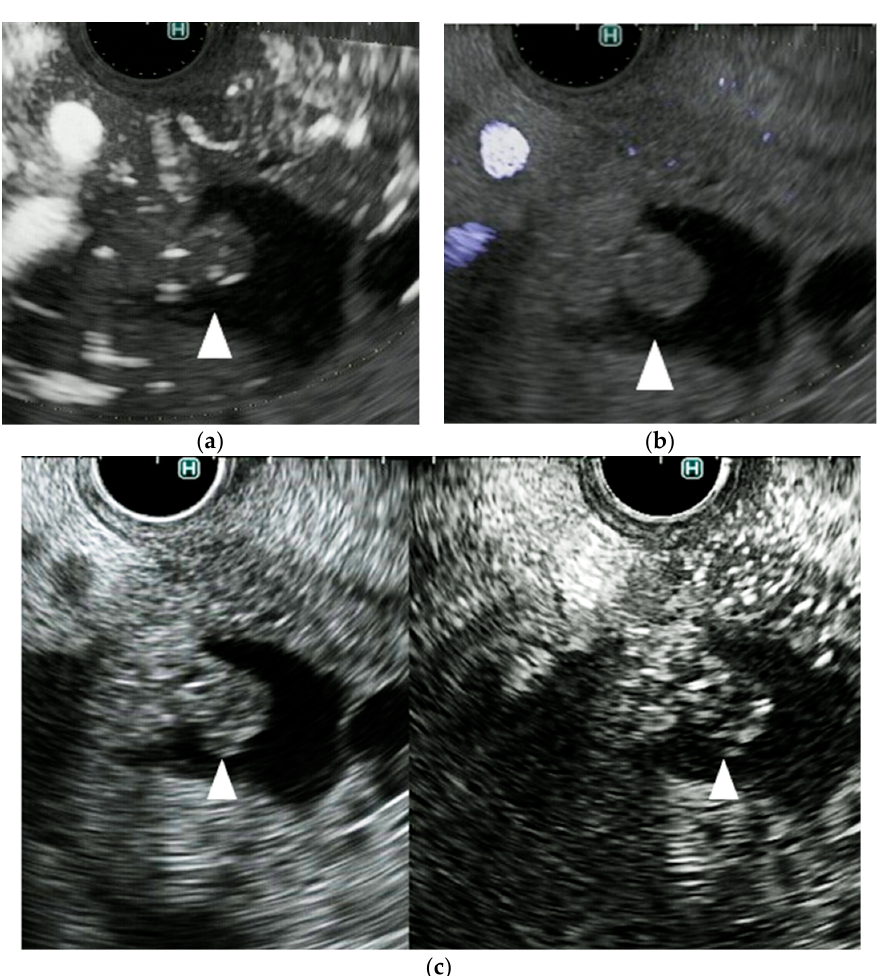
Figure 4. A representative case of a mural nodule in a patient with an intraductal papillary mucin- ous neoplasm (IPMN). ( a ) DFI endoscopic ultrasonography shows vascularity in the mural lesion (arrow). ( b ) e-FLOW endoscopic ultrasonography shows no vascularity in the mural lesion (arrow). ( c ) Contrast-enhanced endoscopic ultrasonography shows vascularity in the mural lesion (arrow).